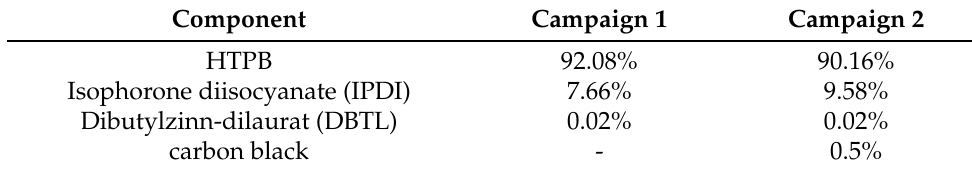
Table 3. Overview over the composition for